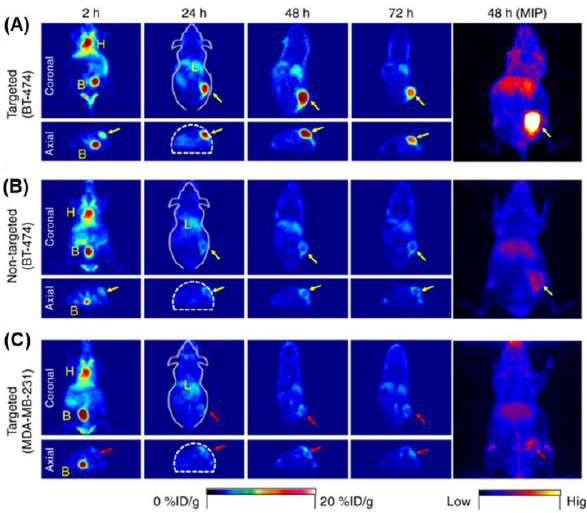
Figure 4. In vivo HER2-targeted PET imaging in xenograft breast cancer models. Serial coronal and axial tomographic PET images acquired at 2, 24, 48, and 72 h post intravenous injection of radiolabeled particle immunoconjugates in groups of tumor-bearing mice (N = 5 for each group), as follows: ( A ) targeted group, 89 Zr-DFO-scFv-PEG-Cy5-C dots in BT-474 mice; ( B ) non-targeted group, 89 Zr-DFO-Ctr/scFv-PEG-Cy5-C dots in BT-474 mice; and ( C ) targeted group, 89 Zr-DFOscFv- PEG-Cy5-C dots in MDA-MB-231 mice. For each group, maximum intensity projection (MIP) images were also acquired at 48 h p.i. H, heart; B, bladder; L, liver. All BT-474 tumors are marked with yellow arrows, while all MDA-MB-231 tumors are marked with red arrows. Reproduced with